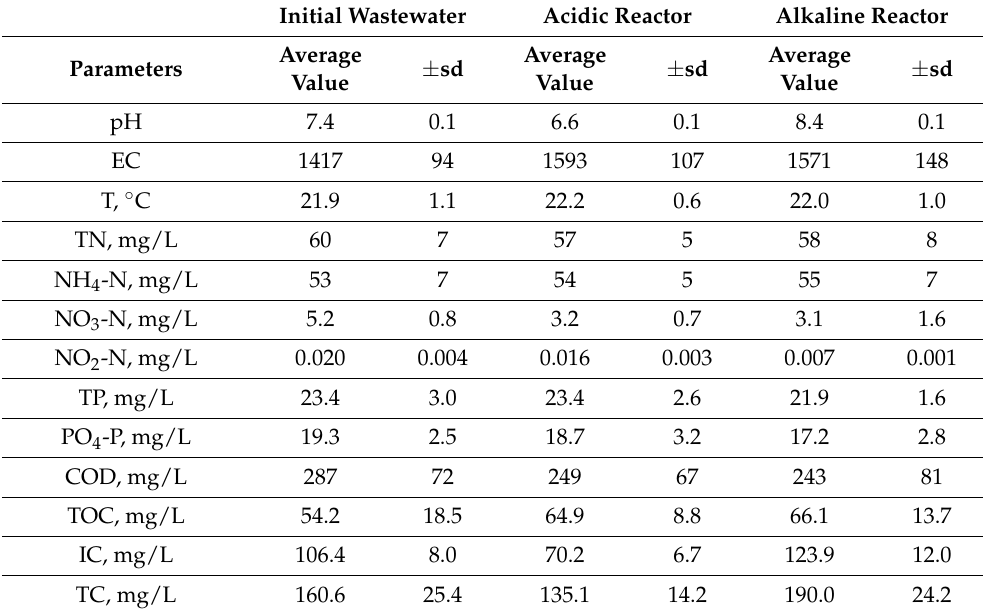
Table 1. Changes in composition of influent wastewater before and after pH regulations (n =